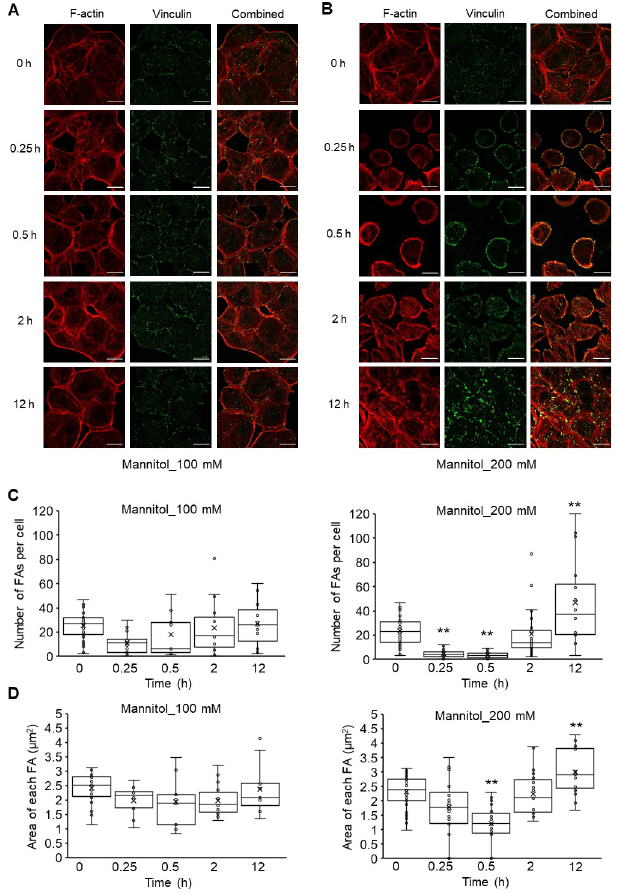
Fig 5. Effects of hyperosmotic mannitol stress on actin and vinculin distribution in NRK-52E cells. (A, B) Cells were cultured with 100 (A) or 200 mM (B) mannitol for 0, 0.25, 0.5, 2, and 12 h. Typical fluorescence images of F-actin (red), vinculin (green), and combined (red and green). Bar, 25 μ m. (C, D) A summary of vinculin staining data from (A) and (B), showing the number of FAs per cell (C) and area of each FA (D) (100 mM; 0 h (n = 25), 0.25 h (n = 13), 0.5 h (n = 9), 2 h (n = 15), 12 h (n = 11): 200 mM; 0 h (n = 33), 0.25 h (n = 28), 0.5 h (n = 27), 2 h (n = 28), 12 h (n = 16)). Data are presented as box and whisker plots with average ( × ), median, IQR and minimum and maximum values. The n indicates the number of cells analyzed. �� P < 0.01 from the data of 0 h (Dunnett’s test).